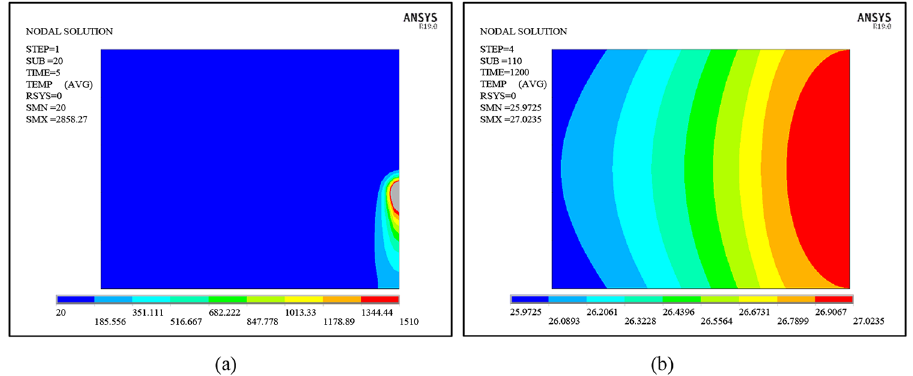
Fig. 5. (a) Temperature distribution at 5 s (during the welding process. Units ° C). (b) Temperature distribution at 1200 s (11min 48 s after the welding process stopped. Unit: ° C).